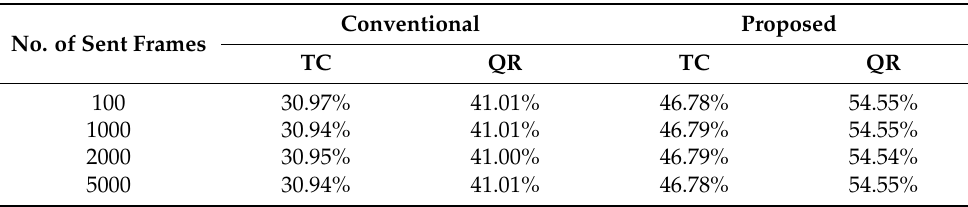
Table 4. Traffic-reduction performance against the numbers of sent frames for the conventional and proposed